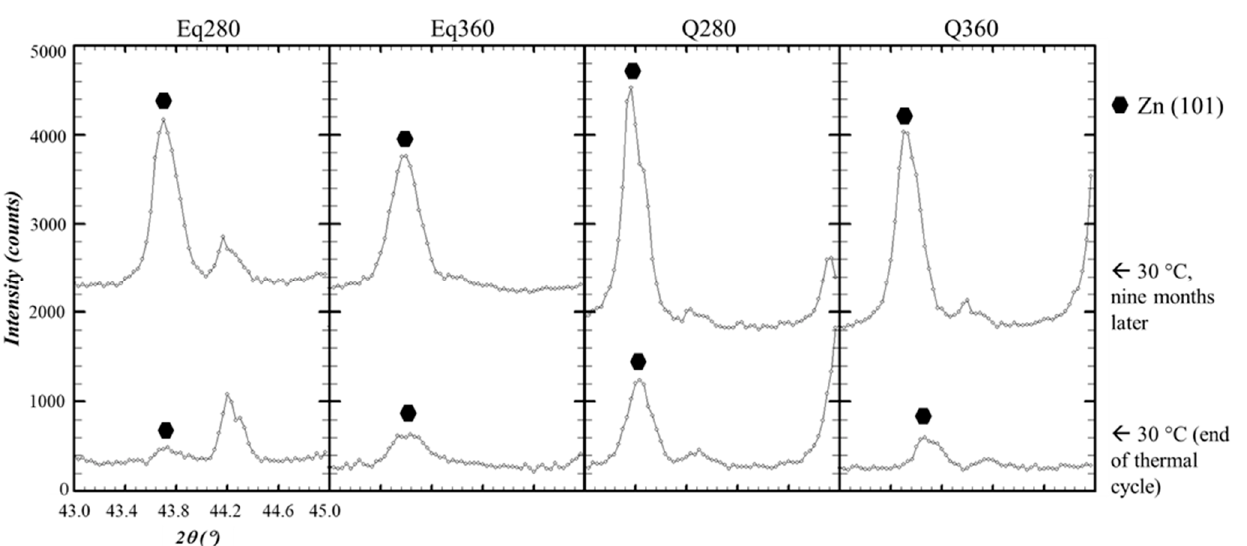
Table 3. Experimental and theoretical temperatures for the reactions observed in the X-ray thermo-diffraction tests.